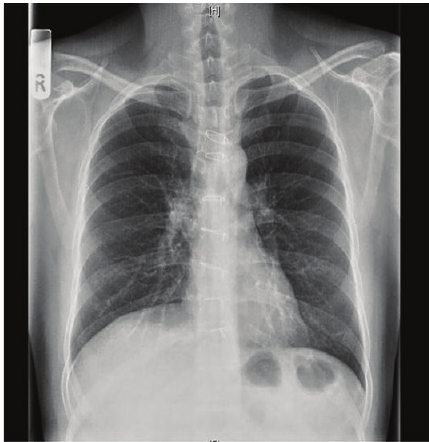
Figure 5: No residual lesion on chest X-ray on